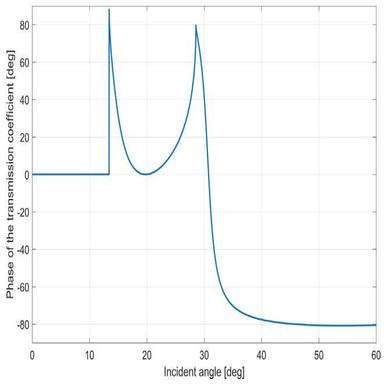
Numerical calculation of the transmission coefficient phase of the shear waves for an aluminum plate (material properties taken from literature C11 = 110 GPa and C44 = 26 GPa). The sharp peaks correspond to the critical angles of the longitudinal (θ = ° 13 ) and the shear wave (θ = ° 28 ).